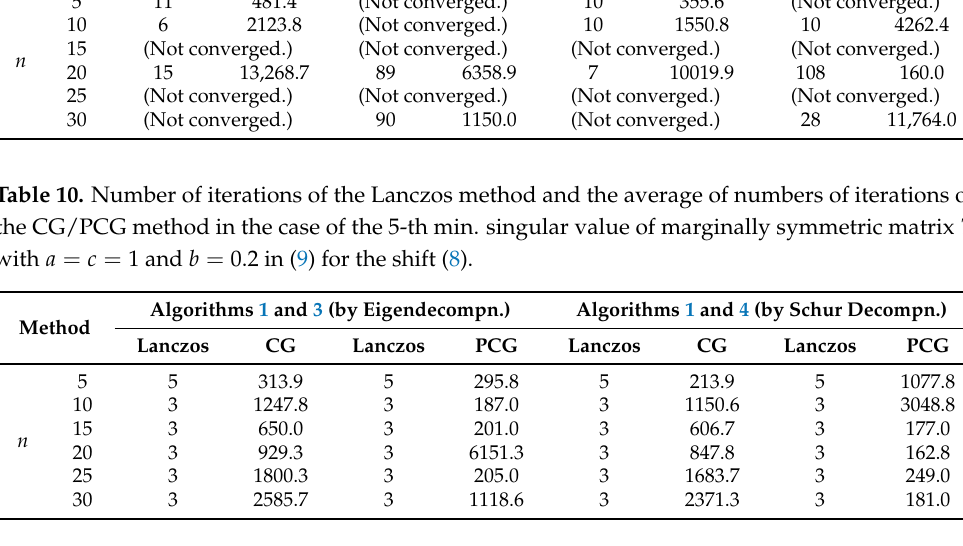
Table 9. Number of iterations of the Lanczos method and the average of numbers of iterations of the CG/PCG method in the case of the median of singular value of marginally symmetric matrix T with a = c = 1 and b = 0.2 in (9) for the shift (8). Algorithms 1 and 3 (by Eigendecompn.) Algorithms 1 and 4 (by Schur Decompn.) Method